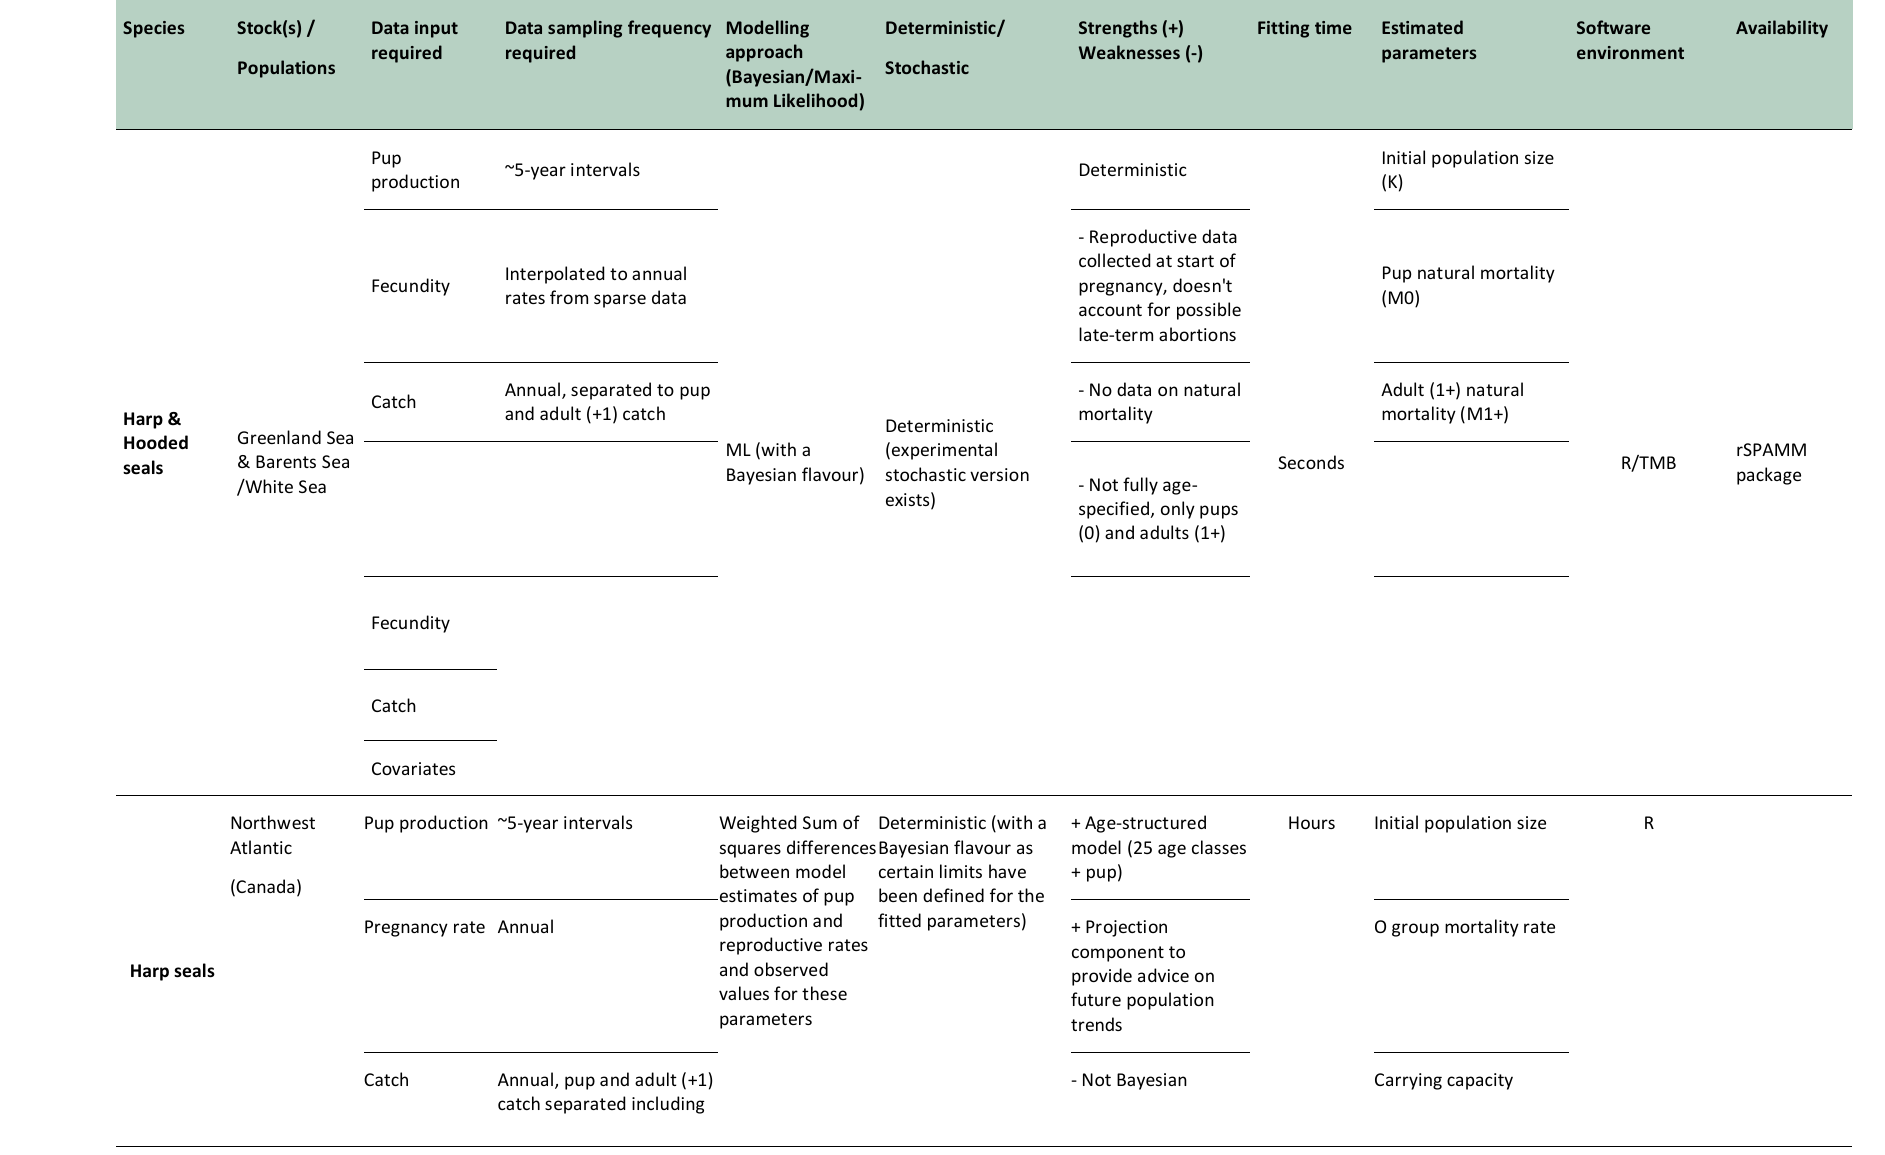
Table 2. Model matrix table for harp and hooded seals.